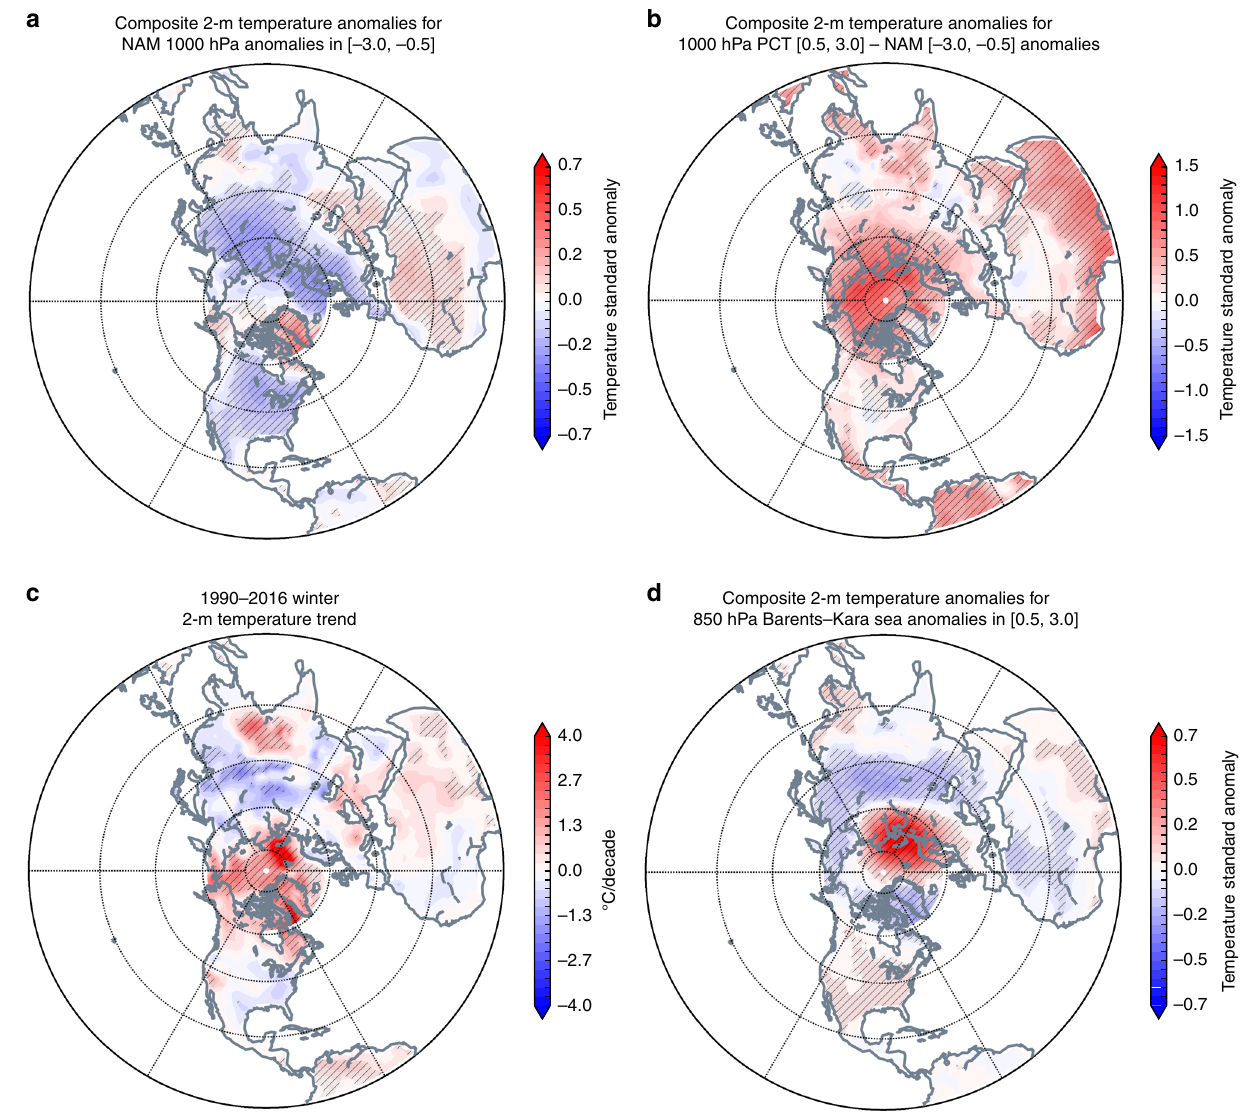
Fig. 10 Arctic ampli fi cation is more closely associated with polar cap temperature than annular mode or warming in the Barents – Kara seas. a Surface temperature anomalies associated with the negative phase of the NAM, b difference in surface temperature anomalies associated with positive PCT at 1000 hPa and the negative NAM, c Northern Hemisphere surface temperatures trends in era of AA (1990 – 2016), d association between surface temperature anomalies across the NH and in the Barents – Kara seas. Climatological averages computed over the period 1981 – 2010. Note differences in scales. Hatching in all fi gures represents those values found to be statistically signi fi cant above 95%. We also tested for fi eld signi fi cance in plots a , b , and d and the differences were found to be highly signi fi cant. Ocean mask was applied south of 60° Methods PCH and PCT were compared to departures from the mean in AWSSI values at individual stations over winter months (DJF) from 1950 to 2016. AWSSI changes Computation of polar cap and severe weather indices . For this study, the were binned (0.25 standard deviation bin width) based on corresponding polar cap area-weighted polar cap geopotential height and air temperature anomalies (PCH anomalies evaluated from 1000 to 10 hPa. To compute statistical signi fi cance, data and PCT) were computed for the months December through February using the used in Fig. 2 and later in Figs. 7 and 10 were detrended by removing the linear National Centers for Environmental Prediction (NCEP) reanalysis at global 2.5° trend in the time series prior to binning the data. Statistical signi fi cance was resolution for latitudes north of 65° N, using the period 1950 to 2016 for analysis 69 . evaluated with a two-tailed Student ’ s t test comparing the positive anomaly bins to Daily anomalies were computed from the 1950 to 2016 daily values using the long- the negative anomaly bins and degrees of freedom were adjusted downwards based term daily mean and standard deviation from the reference period 1981 to 2010. on the autocorrelation in the time series. Most relationships between the polar cap We analyzed the AWSSI for multiple stations across the United States. The variables and winter weather were found to be almost uniformly statistically AWSSI is calculated using several variables 29 and is available from http://mrcc.isws. signi fi cant at p < 0.05. Bin counts were generally well-balanced and on the order of illinois.edu/research/awssi/indexAwssi.jsp. Of those stations analyzed, we chose 12 2000 to 3000 days total across all bins in each of the positive and negative spaces, geographically representative stations across the United States. Those stations are for total counts typically 4000 to 6000 days per station (Fig. 2). displayed on a topographic map created with the open source package matplotlib (https://matplotlib.org) in Fig. 1. In this study, we analyzed the AWSSI (Fig. 2) and the individual components of the AWSSI of surface temperature (Fig. 3) and Lagged correlation analysis . Lagged time analyses were used to demonstrate the snowfall (Fig. 4). The Student ’ s t test was applied to the bins pairwise as described direction of the relationship between positive PCH values and more frequent severe in the text, adjusting downward the degrees of freedom based on the winter weather. Single-day correlations were computed at lags from − 30 to autocorrelation in the time series. +30 days for AWSSI change across all isobaric levels (500 hPa depicted in Fig. 5).